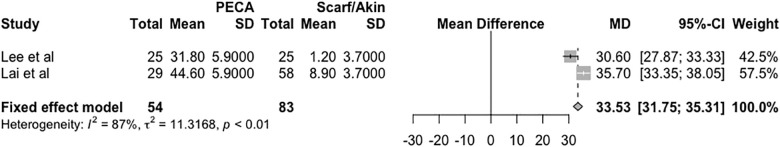
Forest plot of the meta-analysis of the studies evaluating the difference in exposure to intraoperative radiation between the types of surgical procedures.